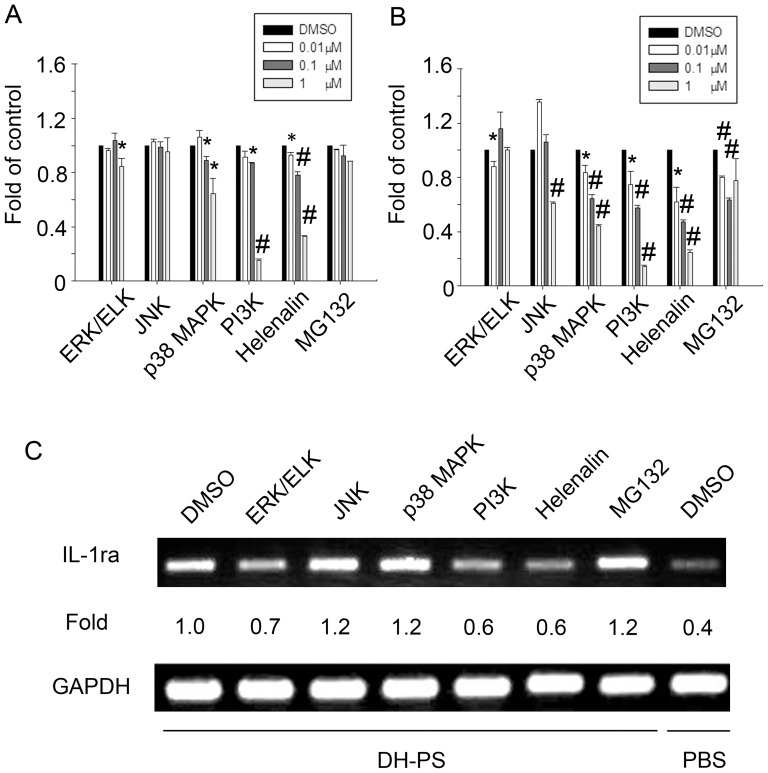
DH-PS induced IL-1ra production through MAPK, PI3K and NF-κB.(A) THP-1 cells (2×106 cells/ml) were pretreated with the indicated concentrations of inhibitors for various kinases including ERK/ELK, JNK, p38 MAPK, PI3K and NFκB (0.01, 0.1 and 1 μM, except for ERK and PI3K: 0.1, 1 and 10 μM) or DMSO (0.1%) as control for 60 minutes and cultured with DH-PS (100 μg/ml) for another 18 hrs (B) Human CD14+ cells were pretreated with the indicated concentrations of inhibitors or DMSO as control like (A) and cultured with DH-PS (100 μg/ml) for another 18 hrs. Supernatants were harvested for IL-1ra measurements. Results were presented as fold of control (Y-axis) derived from the mean values of IL-1ra concentrations of inhibitor-treated groups divided by DMSO control group and error bars showed the standard deviation of triplicate. Statistically significant difference (Mean concentrations of IL-1ra were used for the comparisons): * compared with DMSO-treated group, p<0.05. # compared with DMSO-treated group, p<0.005. (C) THP-1 cells (2×106 cells/ml) were pretreated with inhibitors for ERK/ELK (10 μM), JNK (1 μM), p38 MAPK (1 μM), PI3K (10 μM) and NFκB (1 μM) or DMSO (0.1%) as control and cultured with DH-PS (100 μg/ml) for another 12 hrs. Cells were collected for the assessment of mRNA expression of IL-1ra.